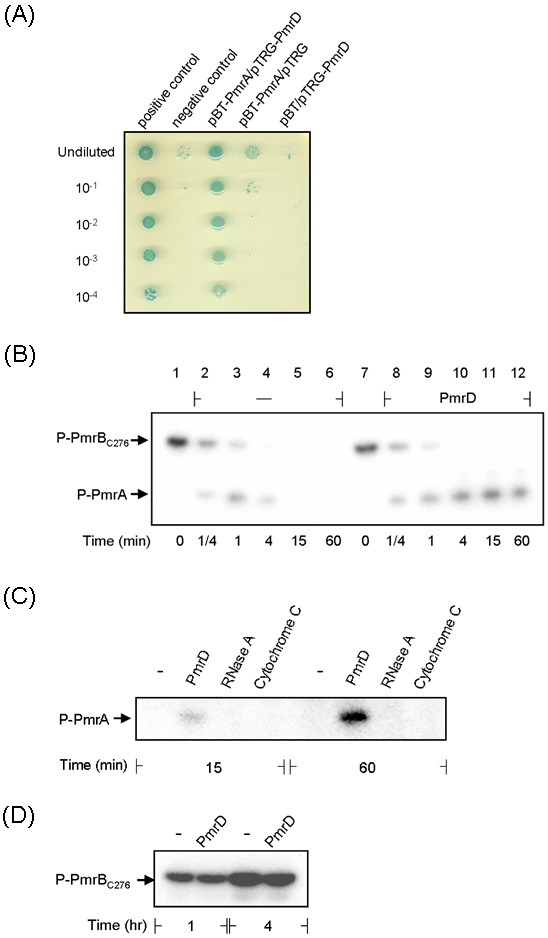
Klebsiella PmrD interacts with PmrA to prevent dephosphorylation. (A) Bacterial two-hybrid analysis of PmrD/PmrA interaction in vivo. The E. coli XL1-Blue cells co-transformed with various combinations of pTRG and pBT-derived plasmids were diluted serially and spotted onto the indicator plate. The bacterial growth after 36 h was investigated and photographed. Combinations of plasmids carried by each strain were indicated above the figure. (B) Klebsiella PmrD prevents the dephosphorylation of PmrA by its cognate sensor protein. The phosphorylation state of the recombinant His-PmrA protein was monitored upon the addition of the sensor protein His-PmrBC276 in the presence (PmrD) or absence (-) of purified His-PmrD protein at specific time points as indicated. The arrows indicate phospho-PmrA (P-PmrA) and phospho-PmrBC276 (P-PmrBC276). (C) Kinase/phosphatase assay was carried out using the recombinant His-PmrA (final concentration 5 μM) and His-PmrBC276 (final concentration 2.5 μM) in the presence (PmrD) or absence (-) of the recombintant His-PmrD protein (final concentration 5 μM). The small cationic proteins RNase A and cytochrome C were introduced individually as a negative control at a final concentration of 5 μM. (D) Autokinase assay of the recombinant His-PmrBC276 (final concentration 2.5 μM) was performed in the presence (PmrD) or absence (-) of the recombintant His-PmrD protein (final concentration 5 μM).